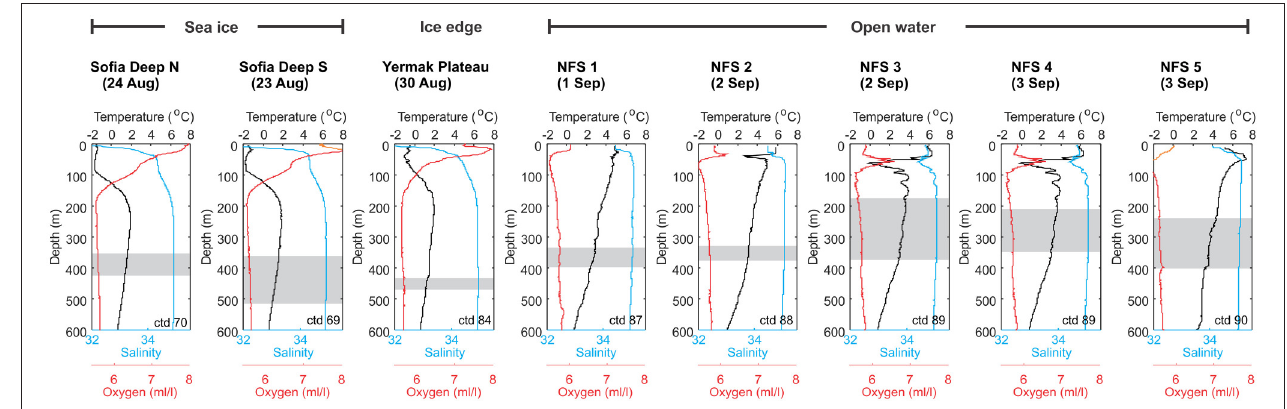
FIGURE 4 | Vertical profiles of temperatures (black line), salinity (green line), and oxygen content (red line) at the eight locations where diel vertical migration of the DSL was studied. The extent of the WMD is shaded on each